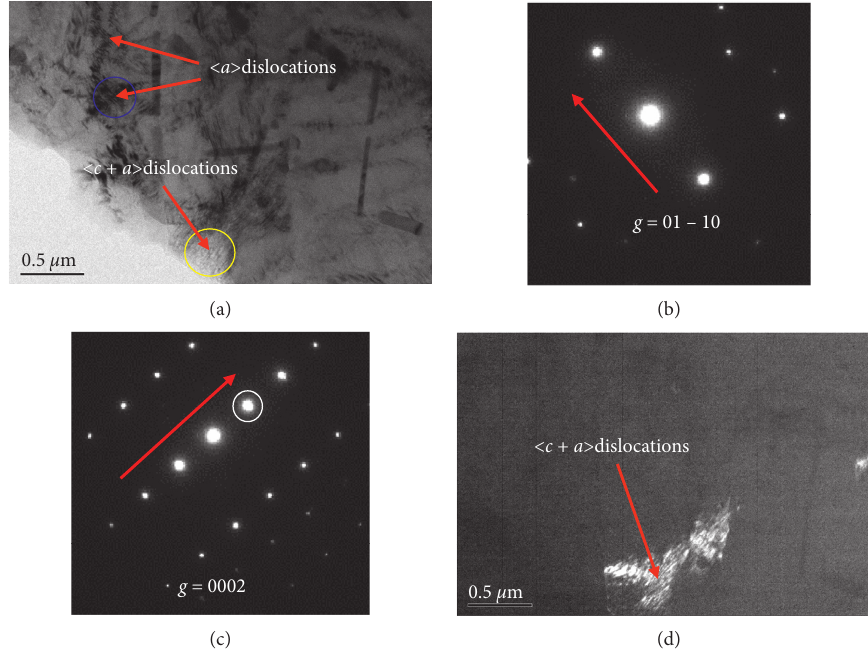
Figure 11: The TEM bright field image (a), selected area electron diffraction (b, c), and the TEM dark field image (d) of the alloy rolled at 400 ° C. < c + a > dislocations were identified in a grain based on the invisibility criterion; < a > dislocations were also found in their vicinity. Two-beam dark-field images were taken along the [2-1-10] zone axis under g � (01-10) and g � (0002),